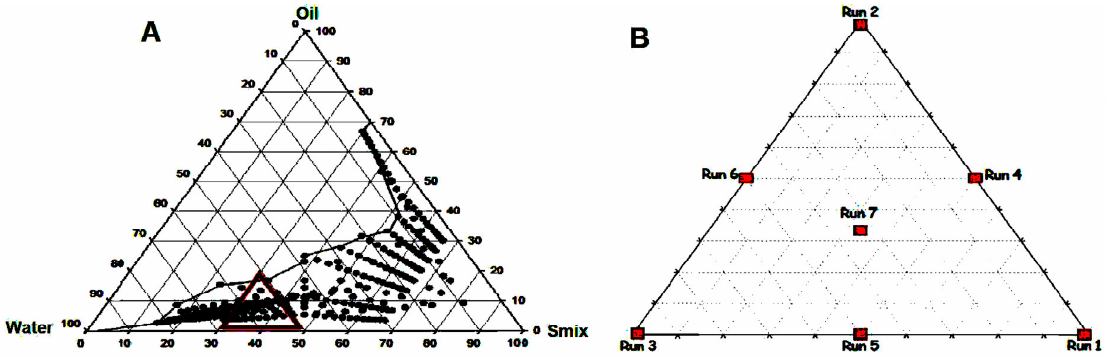
Figure 1. Pseudo ternary phase diagram showing nanoemulsion region ( A ) and distribution for each of run in a mixture design ( B ). Table 1. Formulation composition used for preparing nanoemulsions after applying simplex lattice design.